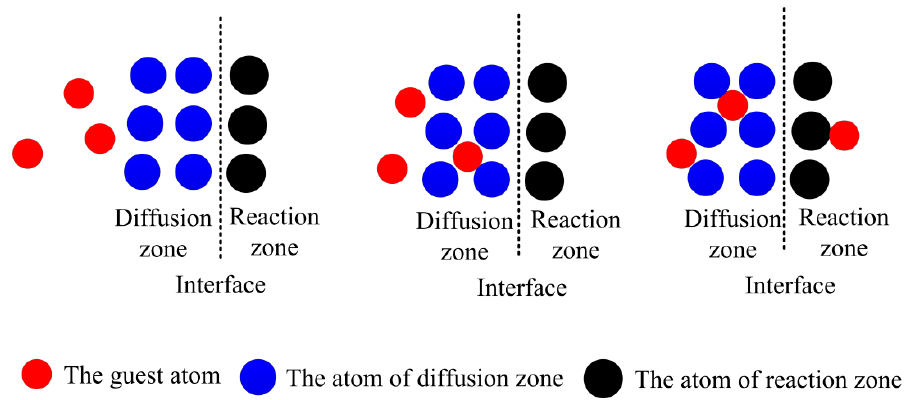
Figure 2. Schematic diagram of oxidation and the diffusion of guest atoms in the long-time service process of thermal barrier coatings (TBCs) in heavy-duty gas turbines.